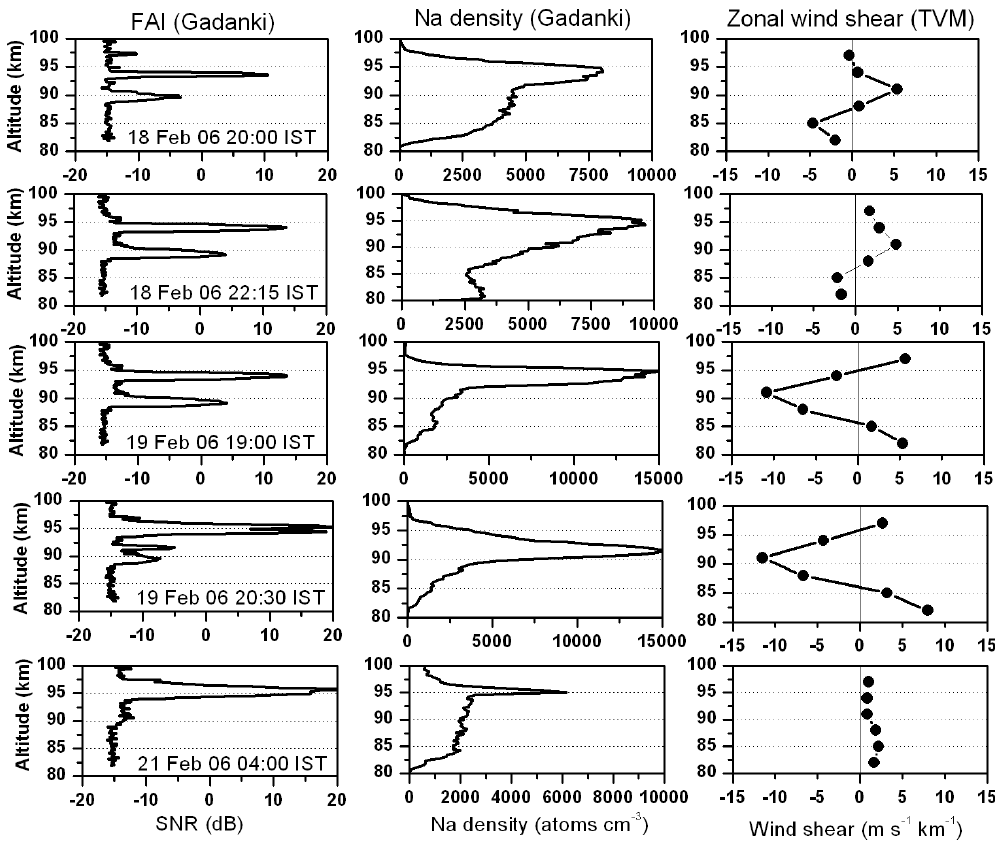
Fig. 5. Altitude profiles of echoes from FAI, Na density over Gadanki and zonal wind shear over Trivandrum at 20:00 and 22:15IST on 18 February 2006, 19:00 and 20:30IST on 19 February 2006 and 04:00IST on 21 February